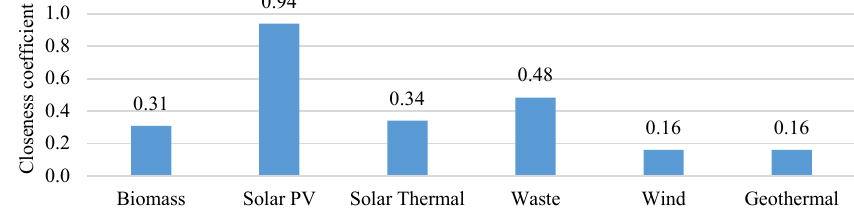
Fig. 2. TOPSIS analysis results – the ranking of RES